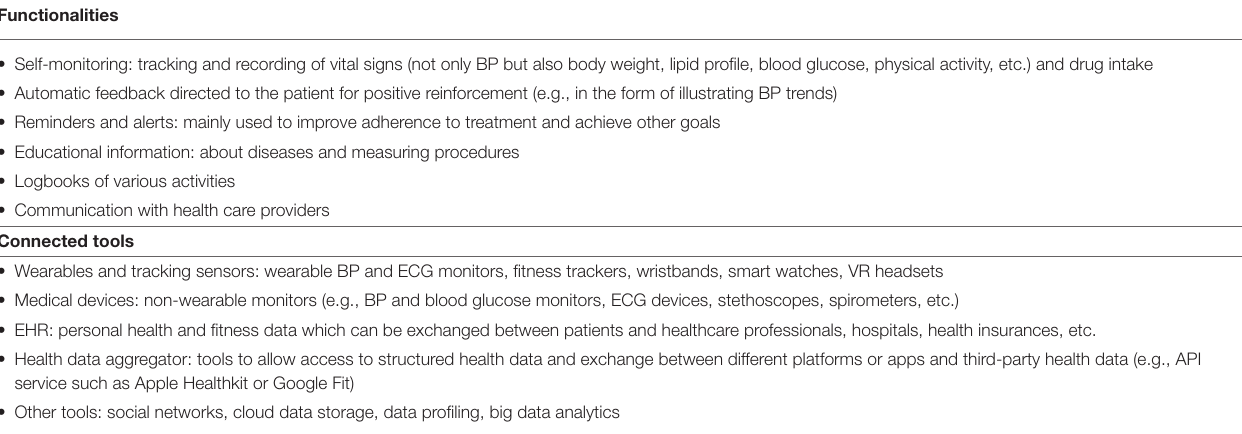
TABLE 4 | Common functionalities provided by m-apps and modalities used to connect health digital data through m-apps.